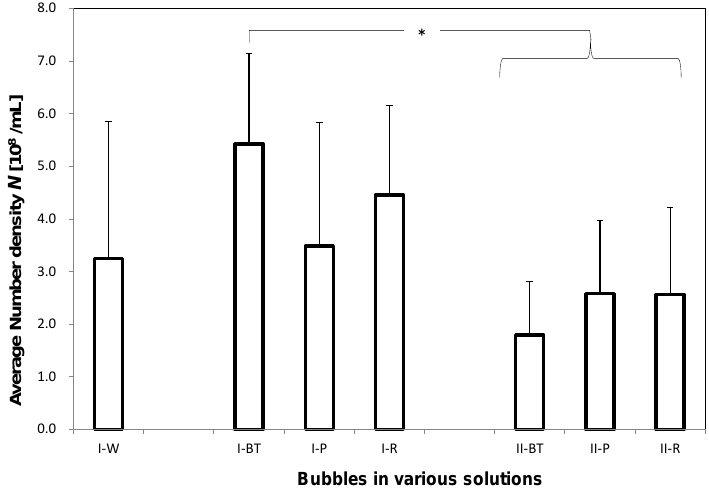
Figure 6. Total fine-bubble number concentration N of each solution. Each error bar shows the standard deviation of measurements. The “*” indicates that a significant difference was observed with the Tukey–Kramer test (Microsoft Excel 2010 and Bell Curve for Excel; p < 0.05).